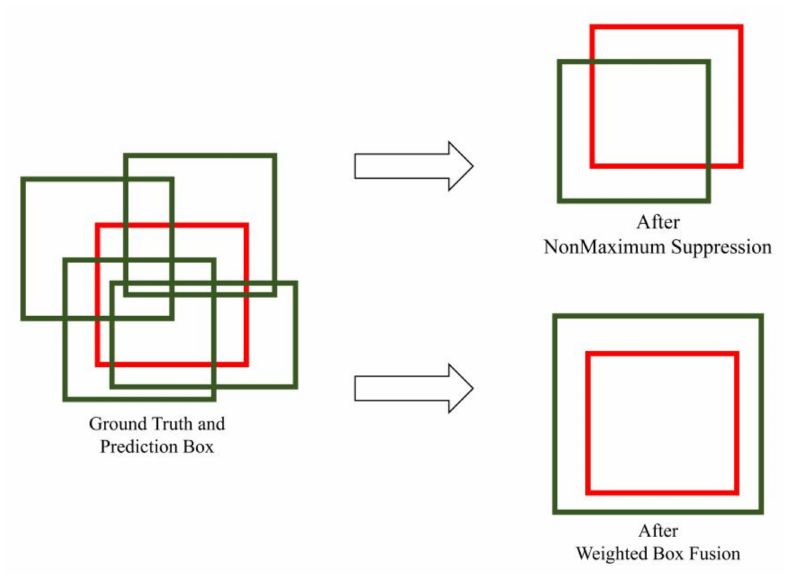
Figure 5. Schematic diagram of nonmaximum suppression (NMS) and weighted boxes fusion (WBF) modified after [47]. Green boxes represent detection boxes, and red boxes represent ground truth boxes.